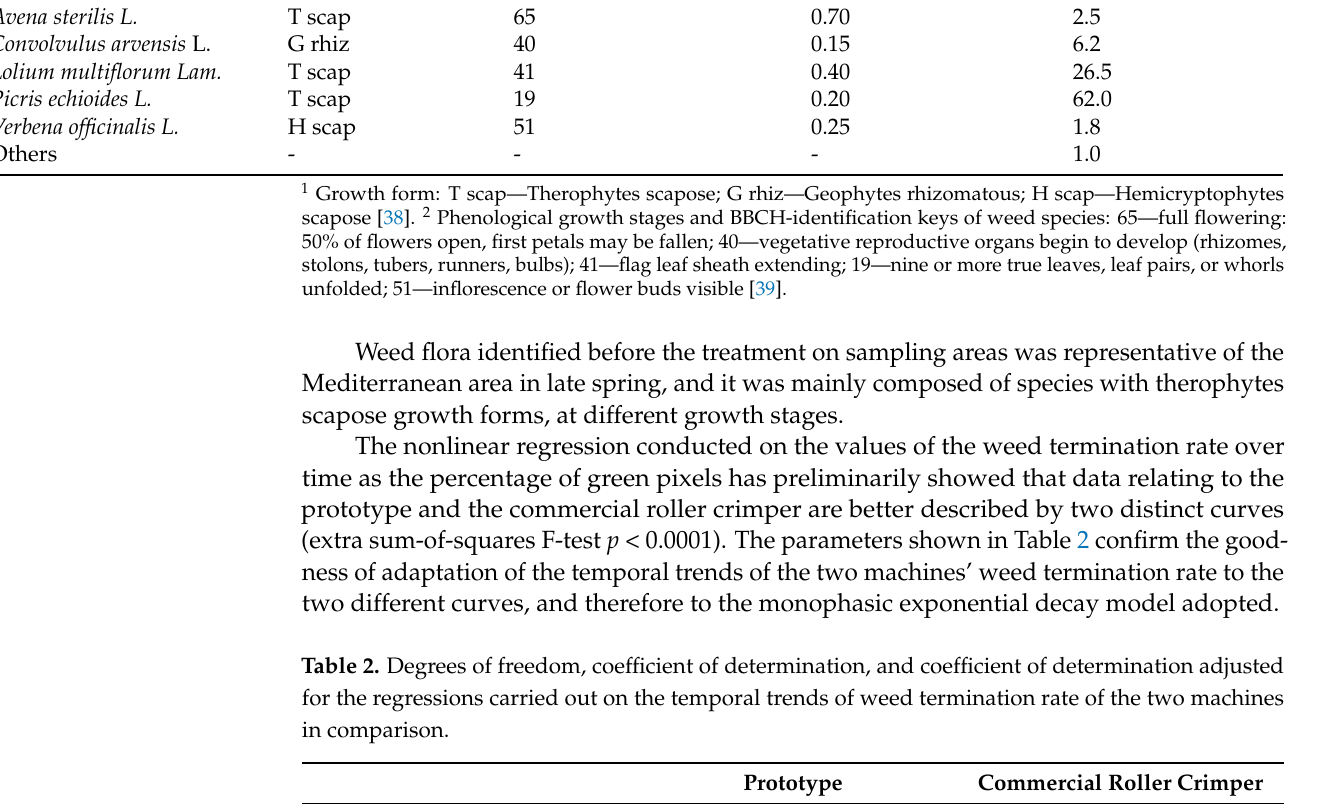
Table 1. Characteristics of the weed flora present on the experimental field before the treatment. Growth Form 1 Growth Stage (BBCH) 2